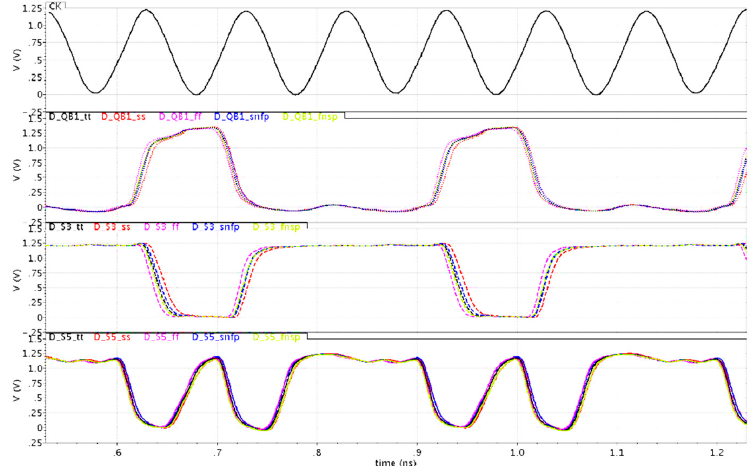
Figure 6. Corner simulation waveform of the proposed prescaler under divide-by-3 (Only process variation: tt, ss, ff, snfp, fnsp).